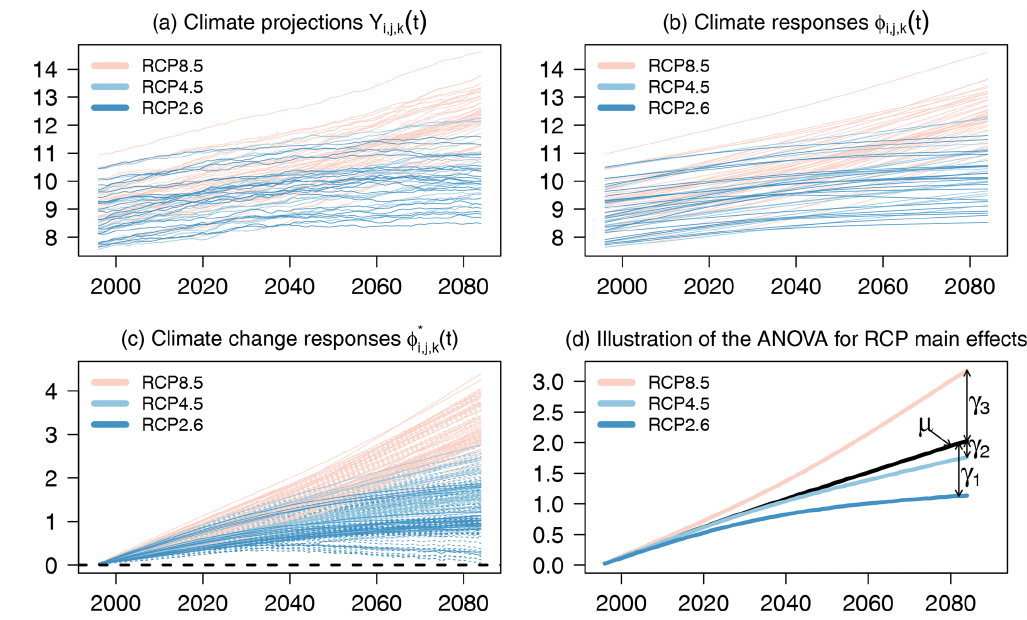
Figure 1. Illustration of the QUALYPSO approach for the MME corresponding to the Mediterranean region (see MED region in Fig. 2 below) in winter for 30-year averages of temperature ( ◦ C). (a) “Raw” climate projections Y i,j,k ( t ). (b) Climate responses φ i,j,k ( t ). (c) Available climate change responses φ ∗ ( t ) (plain lines) and illustration of missing climate change responses (dashed lines). (d) Illustration of the i,j,k ANOVA for RCP main effects. The main RCP effects γ 1 ( t ), γ 2 ( t ), and γ 3 ( t ) represent the deviations from the ensemble mean climate change response µ ( t ) for the emission scenarios RCP8.5, RCP4.5, and RCP2.6, respectively. The dispersion (variance) between γ 1 ( t ), γ 2 ( t ), and γ 3 ( t ) provides an estimate of the scenario